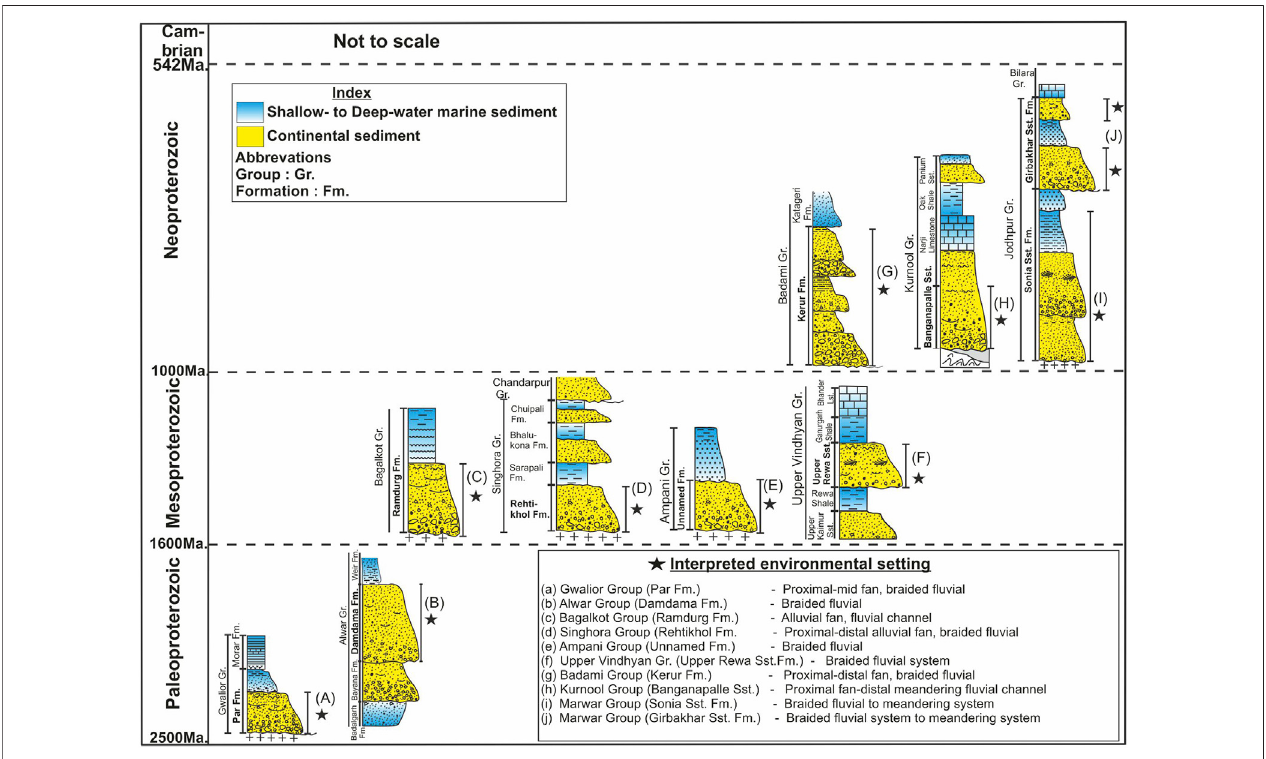
FIGURE 2 | Age-wise classi fi cation of Indian Precambrian sedimentary basins, their generalized stratigraphic successions, and stratigraphic positions from where alluvial deposits are described (marked by asterisks).